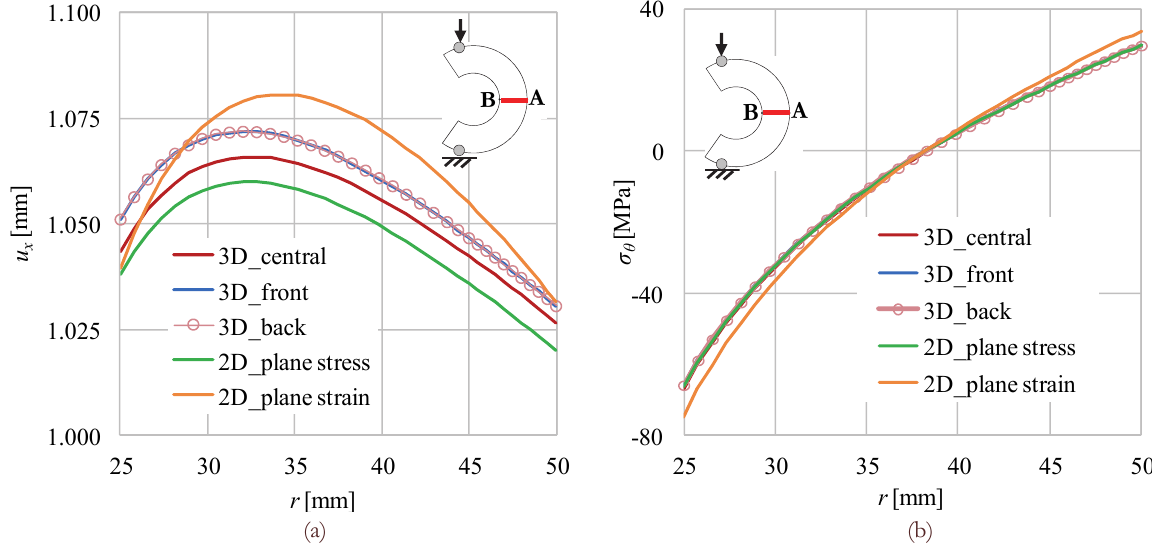
Figure 17: The variation of (a) the horizontal displacement u x ≡ u and (b) the normal transverse stress along the AB locus, according to the reference configuration of the numerical model, assuming either three dimensional conditions (the plots are realized for both the front and rear surfaces and also the central section) or two dimensional conditions (plane stress and plane